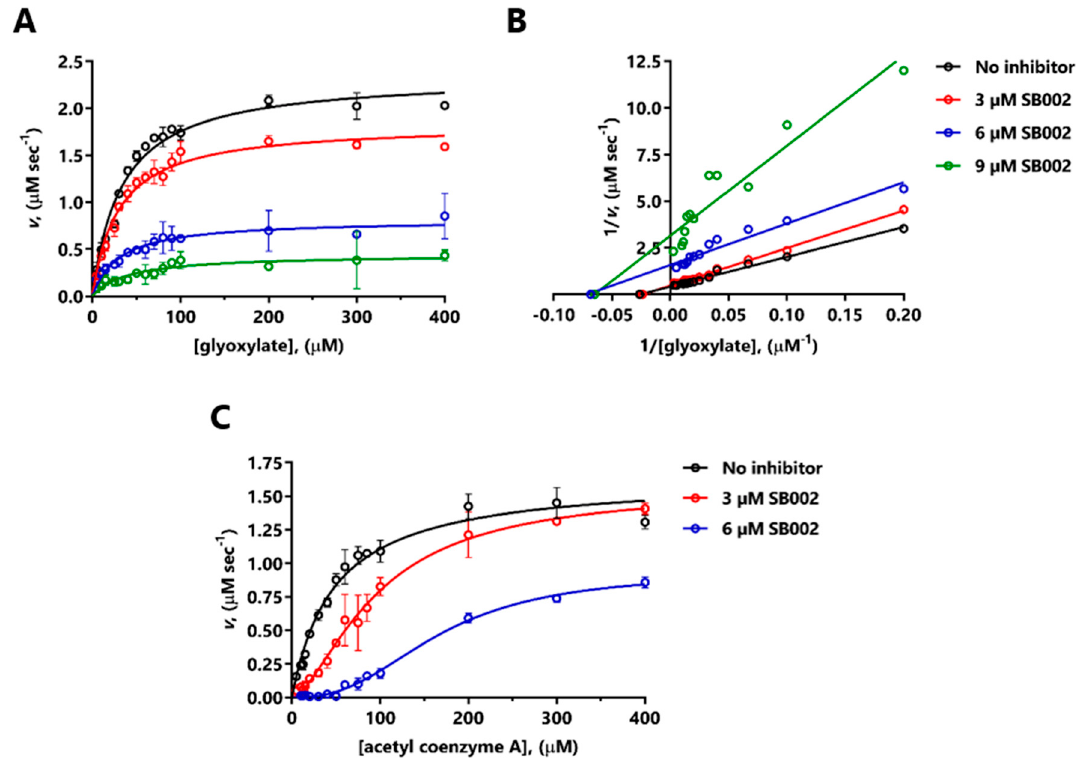
Figure 3. Mode of inhibition of MS Pa by SB002. The figure shows the kinetic data obtained in the presence of the indicated concentrations of SB002 and varying concentrations of glyoxylate at saturating (200 µ M) acetyl-CoA concentration ( A , B ), or acetyl-CoA at saturating (200 µ M) glyoxylate concentration ( C ). ( A ) and ( C ) show the untransformed data, whereas ( B ) shows the data transformed in the fashion of Lineweaver–Burk. Due to the change in the kinetic profile from Michaelis–Menten to sigmoidal in ( C ), we did not carry out a Lineweaver–Burk